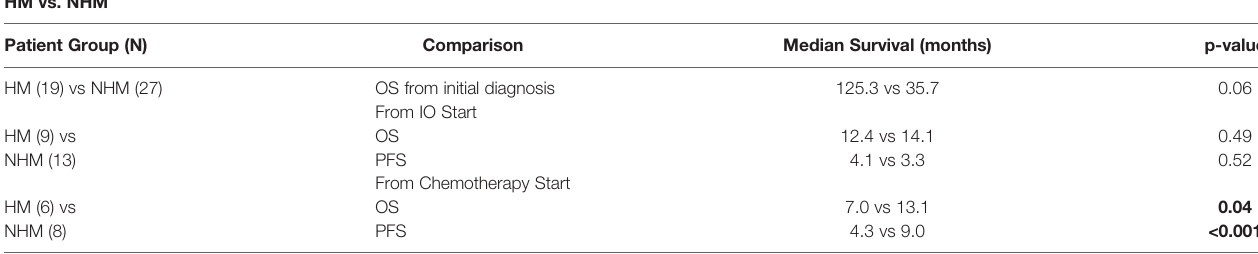
TABLE 3 | Comparison of outcomes in hypermutated vs non-hypermutated patients. HM vs.